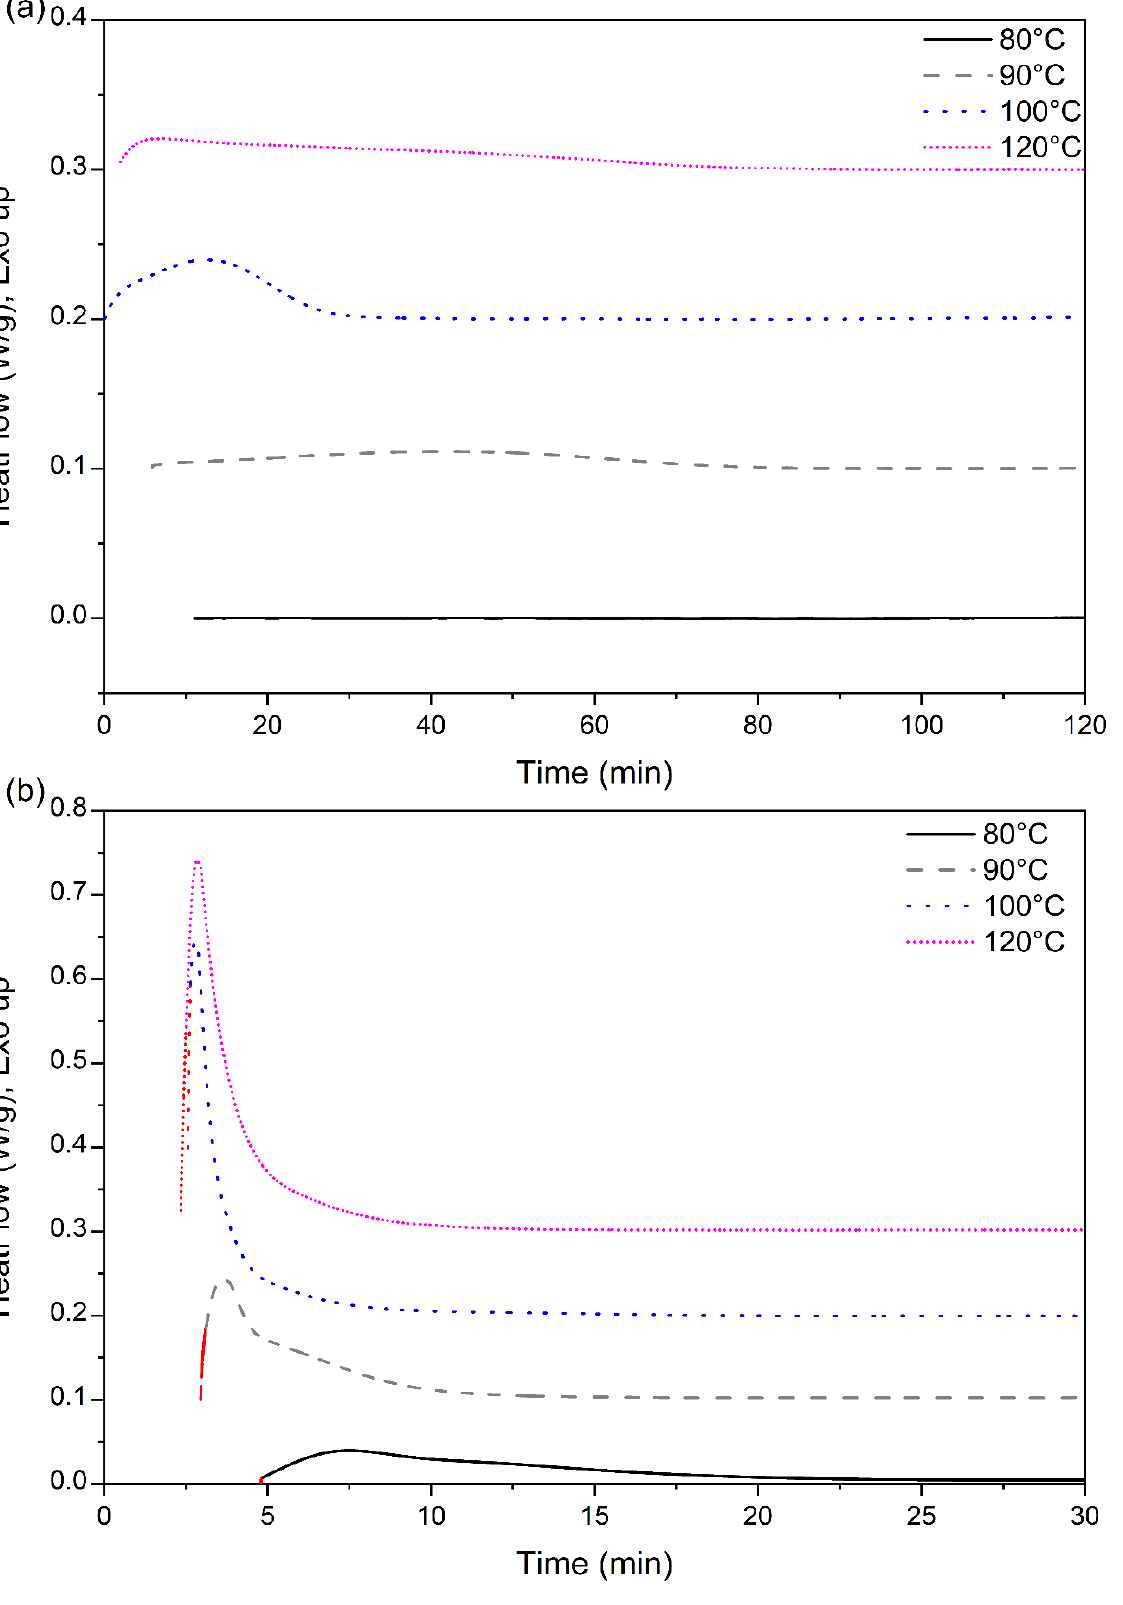
Figure 6. Heat flow data of ( a ) neat PLA, and ( b ) PLA-OA blend at different isotherm temperatures.